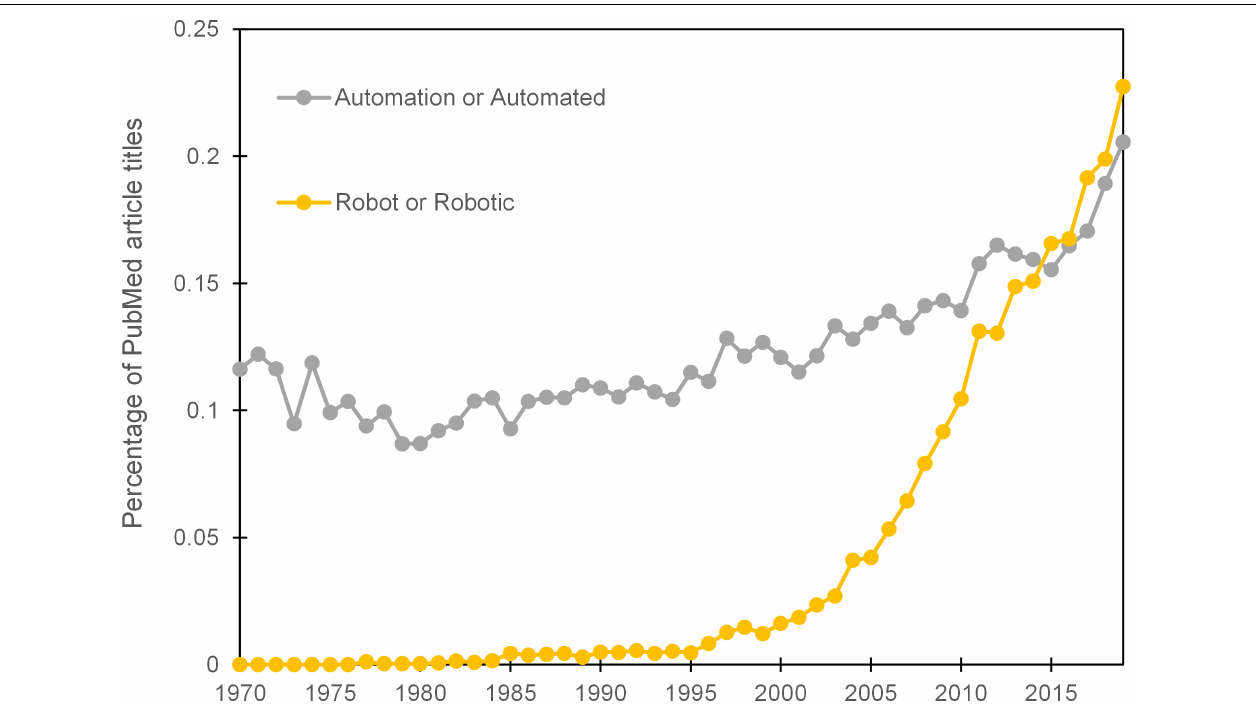
FIGURE 1 | Prevalence of terms ‘automation’ or ‘automated’ and ‘robot’ or ‘robotic’ within the titles of PubMed articles per year over the period 1970–2019.